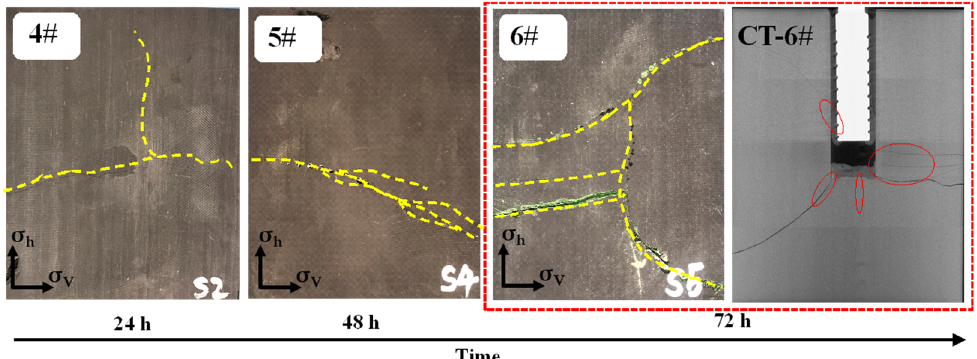
Figure 7. The fracture morphologies of specimens 4#, 5#, and 6#: the number and complexity of fractures increase with the hydration